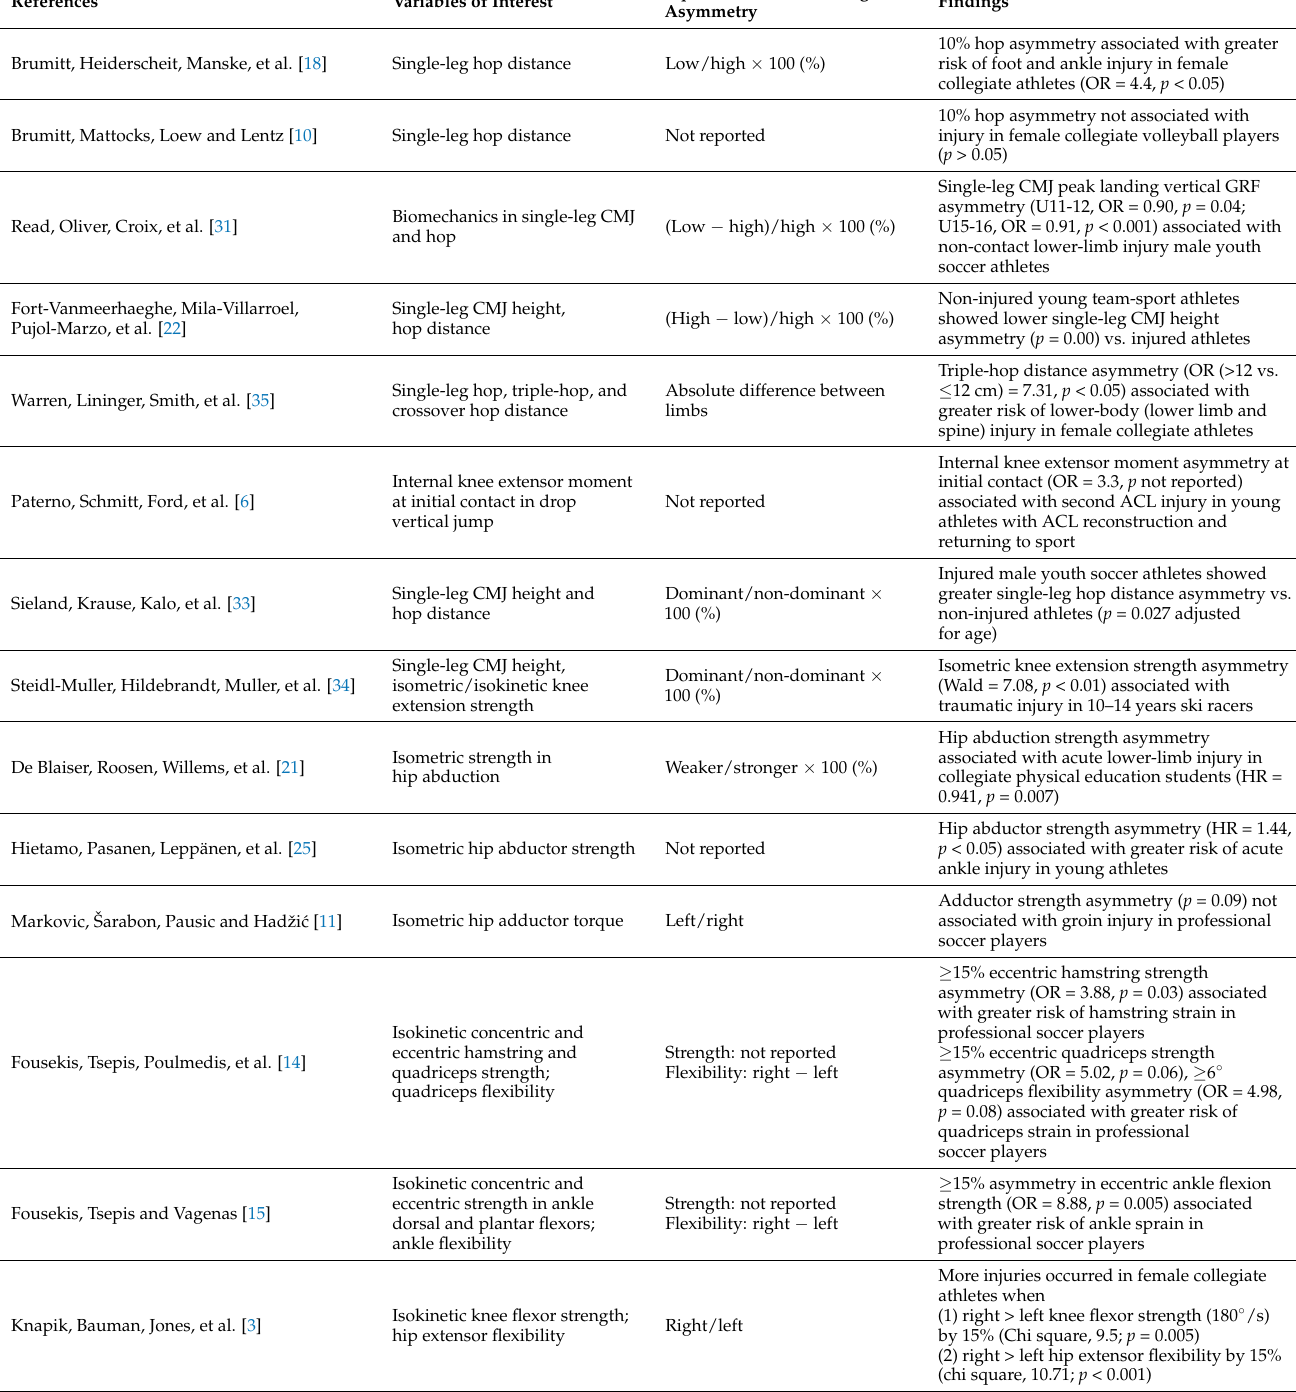
Table 4. Study results—inter-limb asymmetries in lower-limb strength/power and muscle